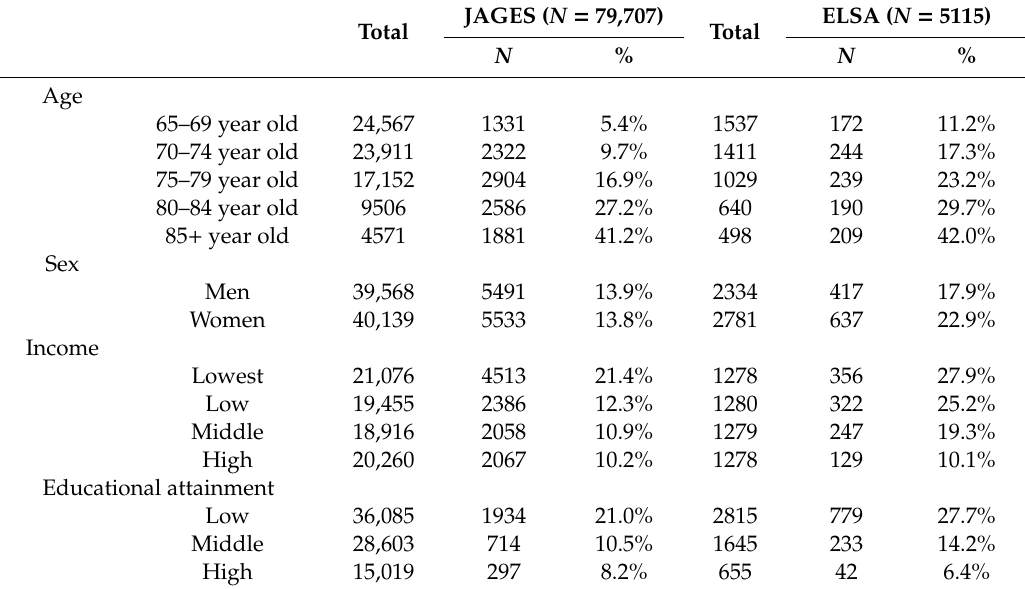
Table 1. Descriptive distribution of edentulous participants in Japan and